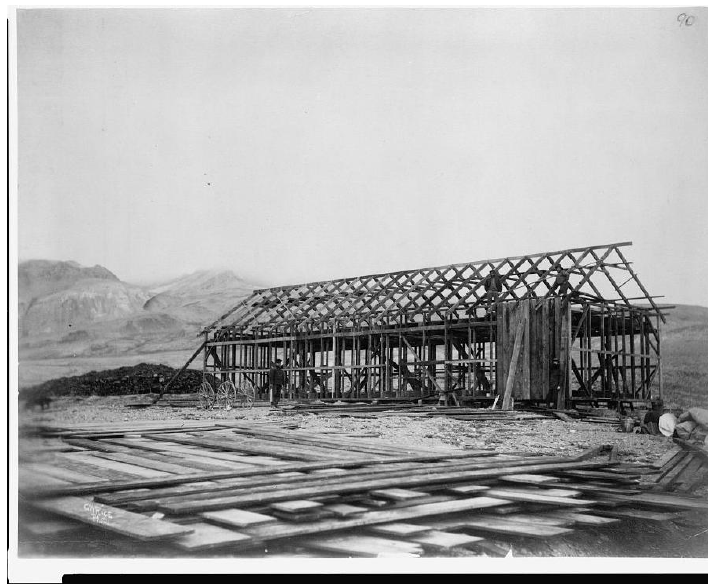
Figure 7. Historic photograph of Greely’s station house under construction.